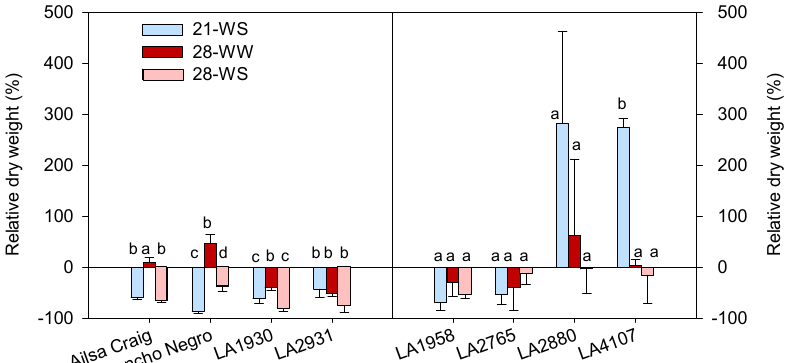
Figure 4. Effect of temperature and water stress on plant dry weight of S. lycopersicum cultivars and S. chilense populations: relative values to the control condition (21-WW) for each accession. Plants were grown at 21 ◦ C under well-watered (21-WW) and water-stressed (21-WS) conditions or at 28 ◦ C under well-watered (28-WW) and water-stressed (28-WS) conditions. Treatments followed by different letters are significantly different at p < 0.05 for the same accession (considering that the control plants are a). Data ± SE.